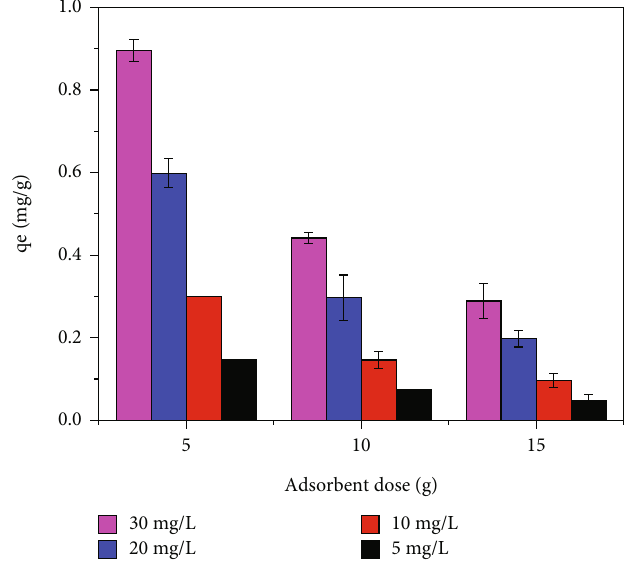
Figure 5: Adsorption capacity of